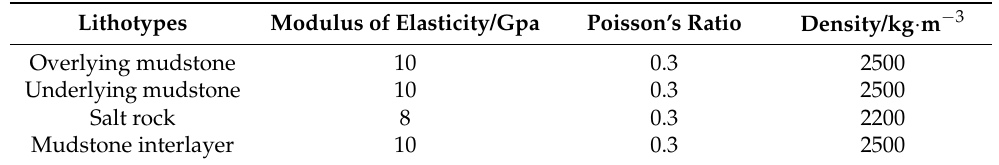
Table 1. Rock mechanical properties.